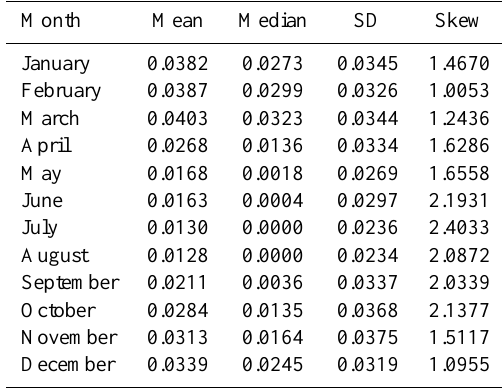
Table 3. Monthly statistics for σ 2